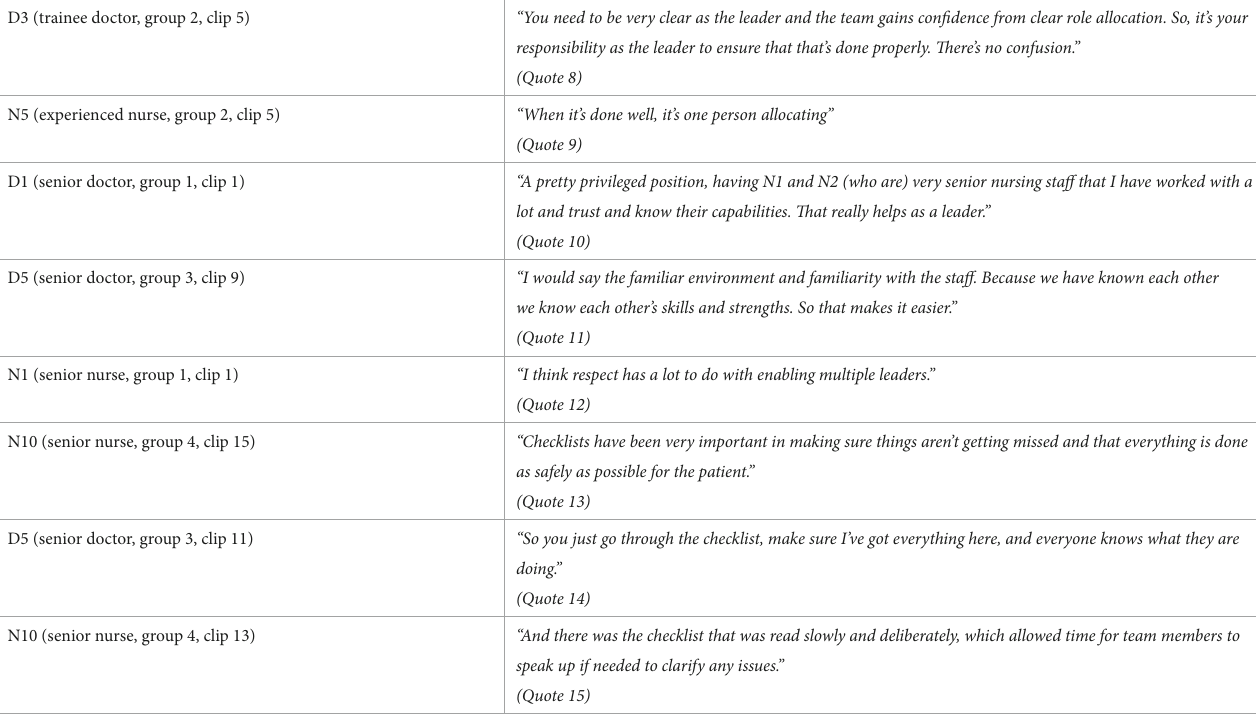
TABLE 6 Illustrative quotes (facilitators of